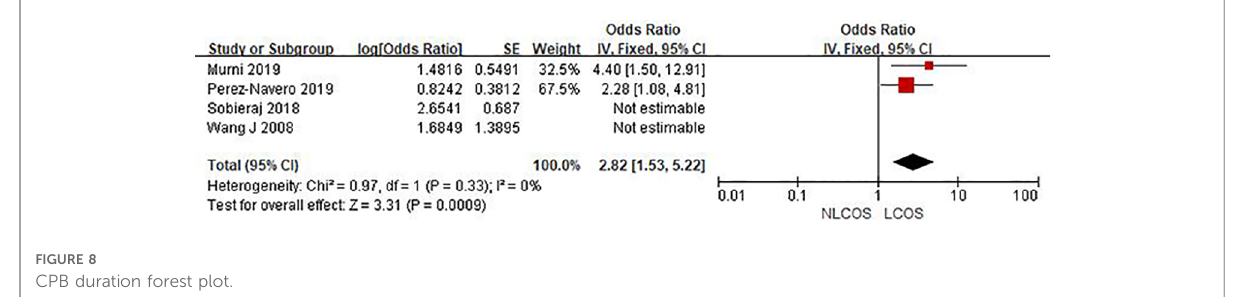
FIGURE 8 CPB duration forest plot.